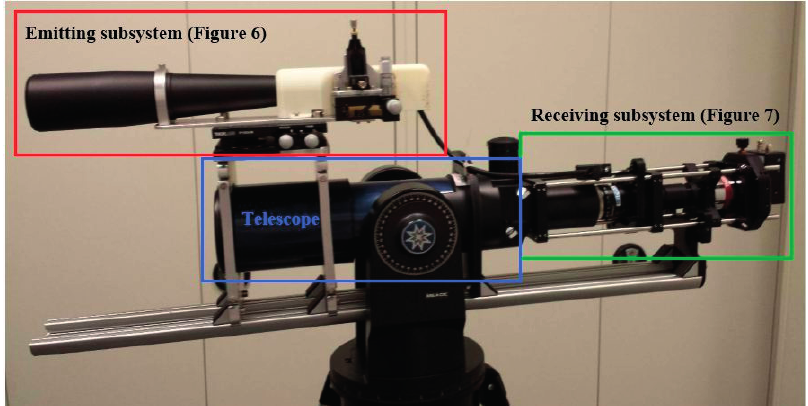
Figure 5. Picture of the lidar prototype showing the emitting and receiving